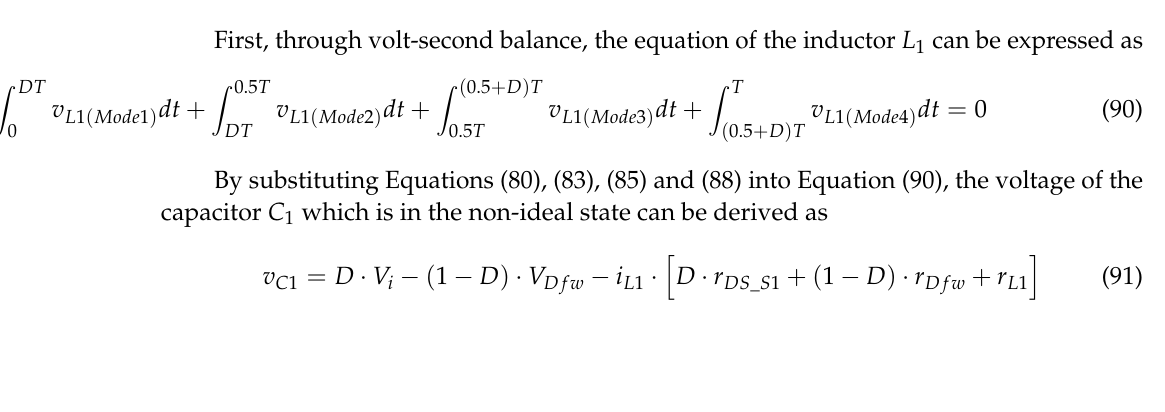
15 of 27 Figure 16. Equivalent circuit operating during [ DT , 0.5 T ]. Mode 3 [0.5 T , (0.5+ D ) T ] In this interval, the main switch S